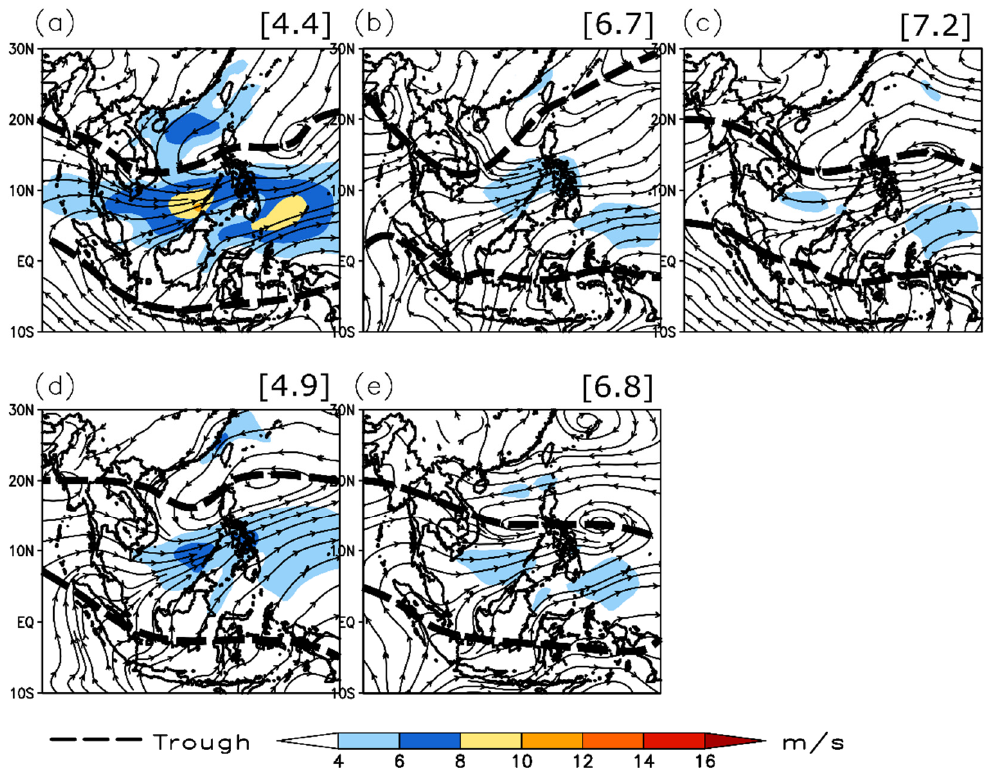
Figure 9. Composite of 925-hPa anomalous wind streamline charts of all collected BSL days during the presence of TCs in ( a ) May, ( b ) June, ( c ) July, ( d ) August, and ( e ) September from the year 1998 to 2018. The average frequency (day) of BSL per month is indicated in the bracket at the upper corner of each panel. Blue to red shaded area indicates stronger wind speed, while monsoon trough is denoted by a black, thick-dashed line.